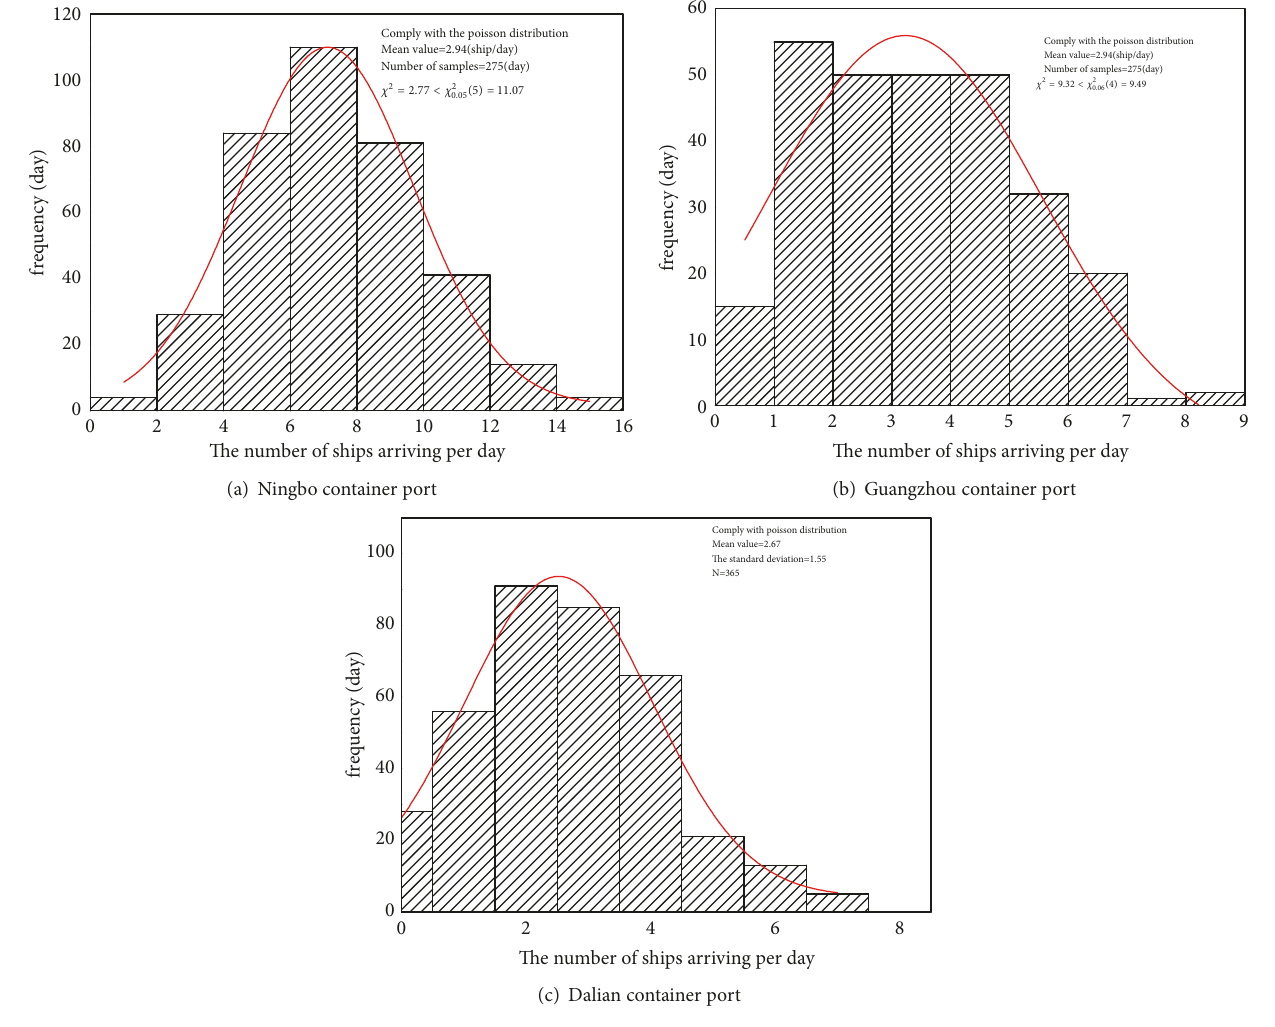
Figure 9: Poisson distribution of the number of arrival ships.